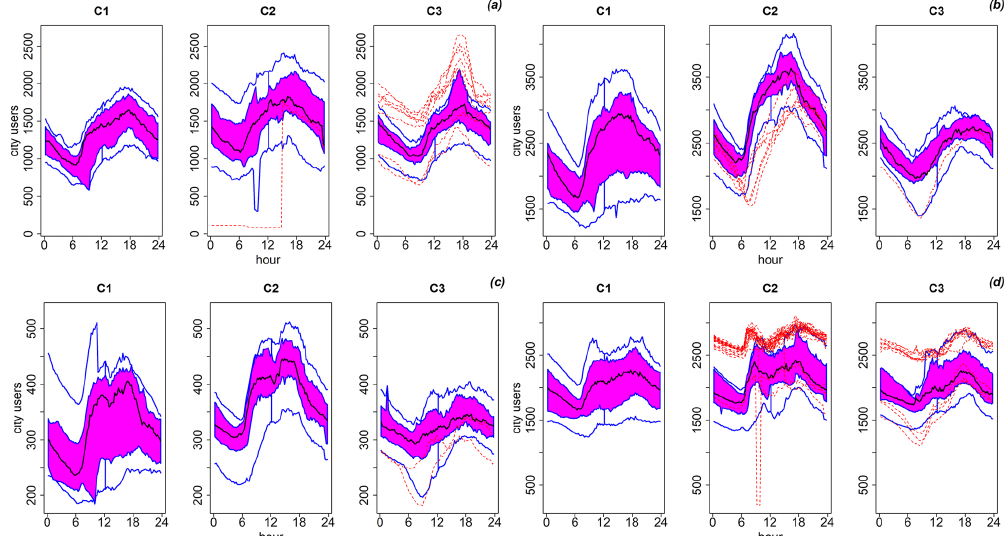
Figure 7. Functional box plots of exposed people (“city users”) inside industrial–commercial settlements: (a) Moie di Sotto (area 5 in Fig. 2), (b) Villaggio Badia and Fantasina (area 6 in Fig. 2), (c) southern Gandovere canal (area 8 in Fig. 2), (d) Roncadelle (area 4 in Fig. 2). Cluster 1 (July, August, September; C1), cluster 2 (working days from October to June; C2), cluster 3 (weekends from October to June;